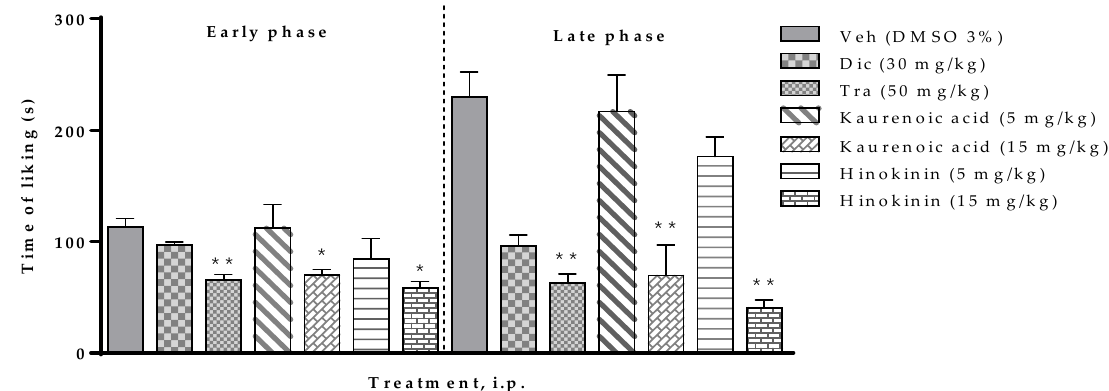
Figure 4. E ff ect of the kaurenoic acid and hinokinin (5 and 15 mg / kg, i.p.) from Aristolochia odoratissima Figure 4. Effect of the kaurenoic acid and hinokinin (5 and 15 mg/kg, i.p.) from Aristolochia odoratissima in